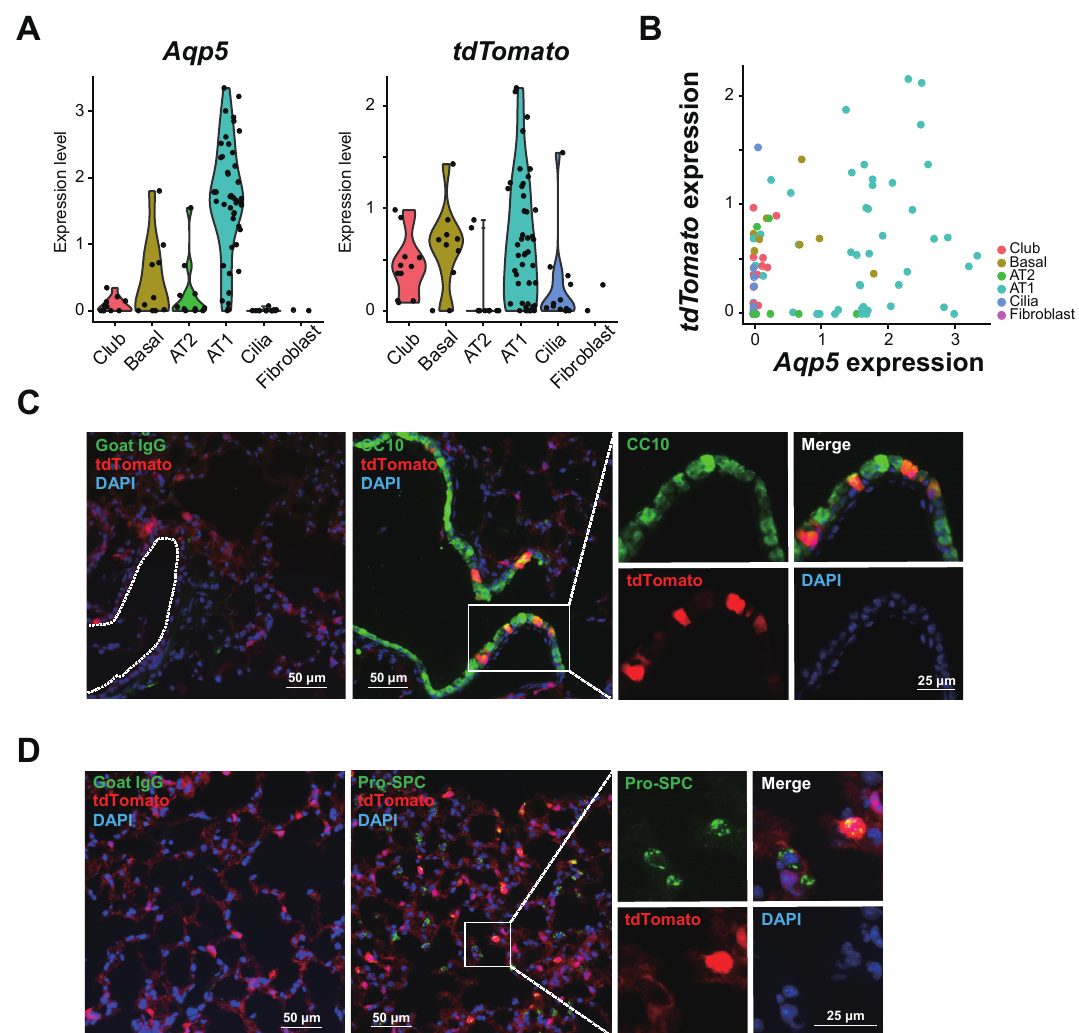
Figure 3. TdTomato expression in ACID;R26tdTomato mouse lung. ( A ) Violin plot for Aqp5 (left) and tdTomato (right). ( B ) Scatter plot between Aqp5 and tdTomato expression. ( C ) Immunofluorescence staining shows CC10 (green) and tdTomato (red) expression in ACID;R26tdTomato mouse lung. Goat IgG (left panel) was used as negative control. White dotted line indicates outline of airway. ( D ) Immunofluorescence staining shows pro-SP-C (green) and tdTomato (red) expression in ACID;R26tdTomato mouse lung. Goat IgG (left panel) was used as negative